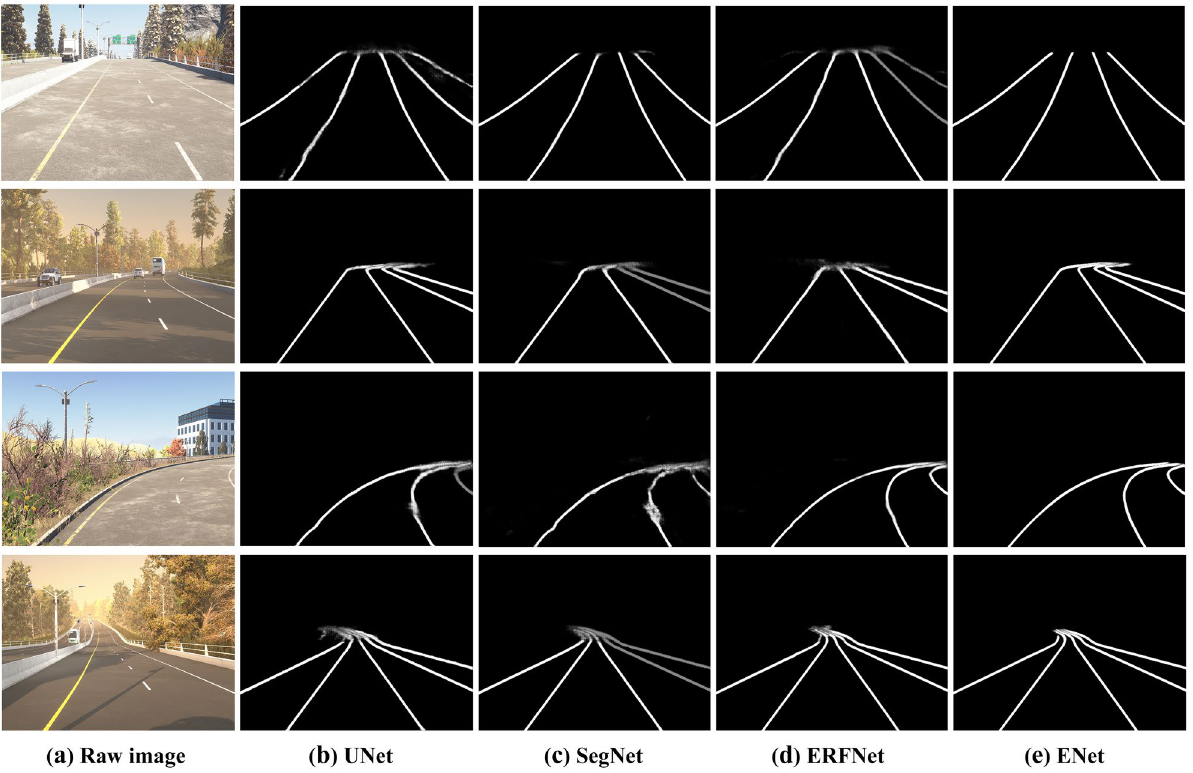
Figure 8. Visualization of lane semantic segmentation for complex traffic scenes. The modeling results of ( b ) UNet, ( c ) SegNet, ( d ) ERFNet and ( e ) ENet performed by Python 3.7 and PyTorch